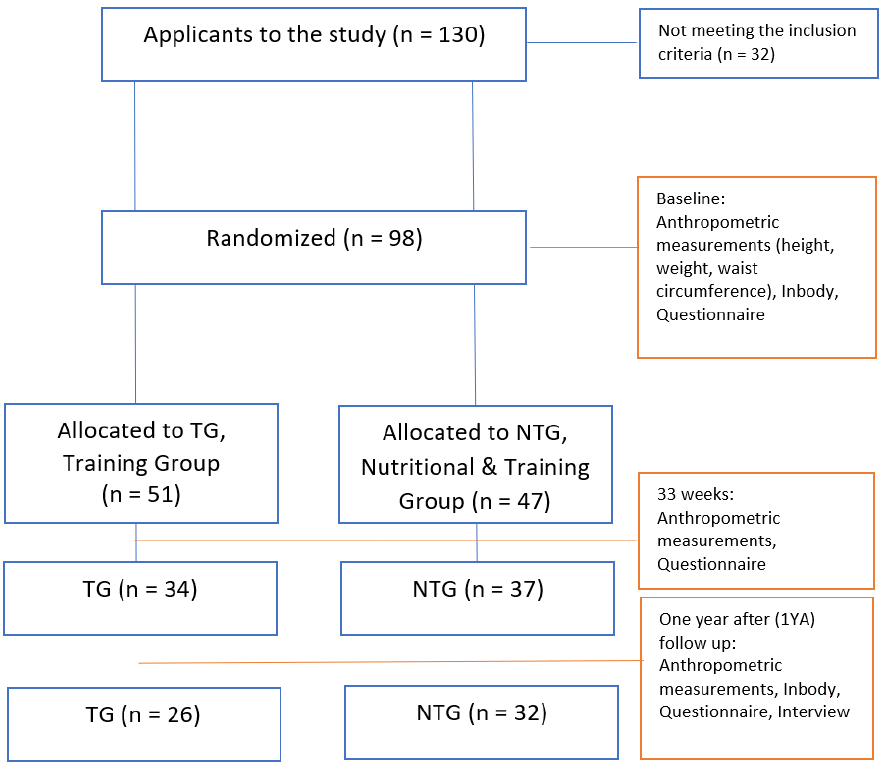
Figure 1. Flow charts of participants and measurements through the study. Details regarding anthropometric measurements and running time can be found in Helland et al. [26], Nordbotten et al. [27], and Saxeide [28].